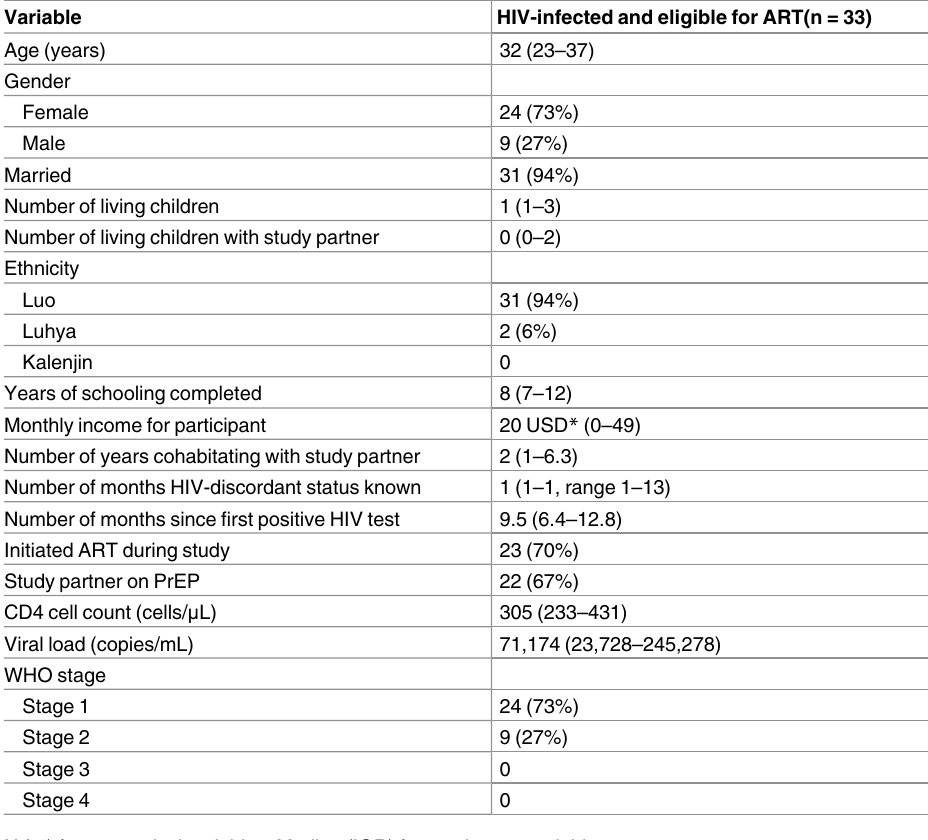
Table 1. Baseline characteristics of